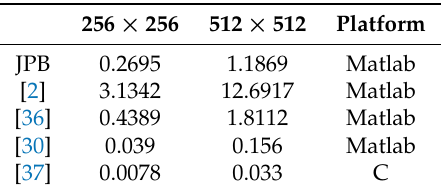
Table 6. Encryption time(seconds).